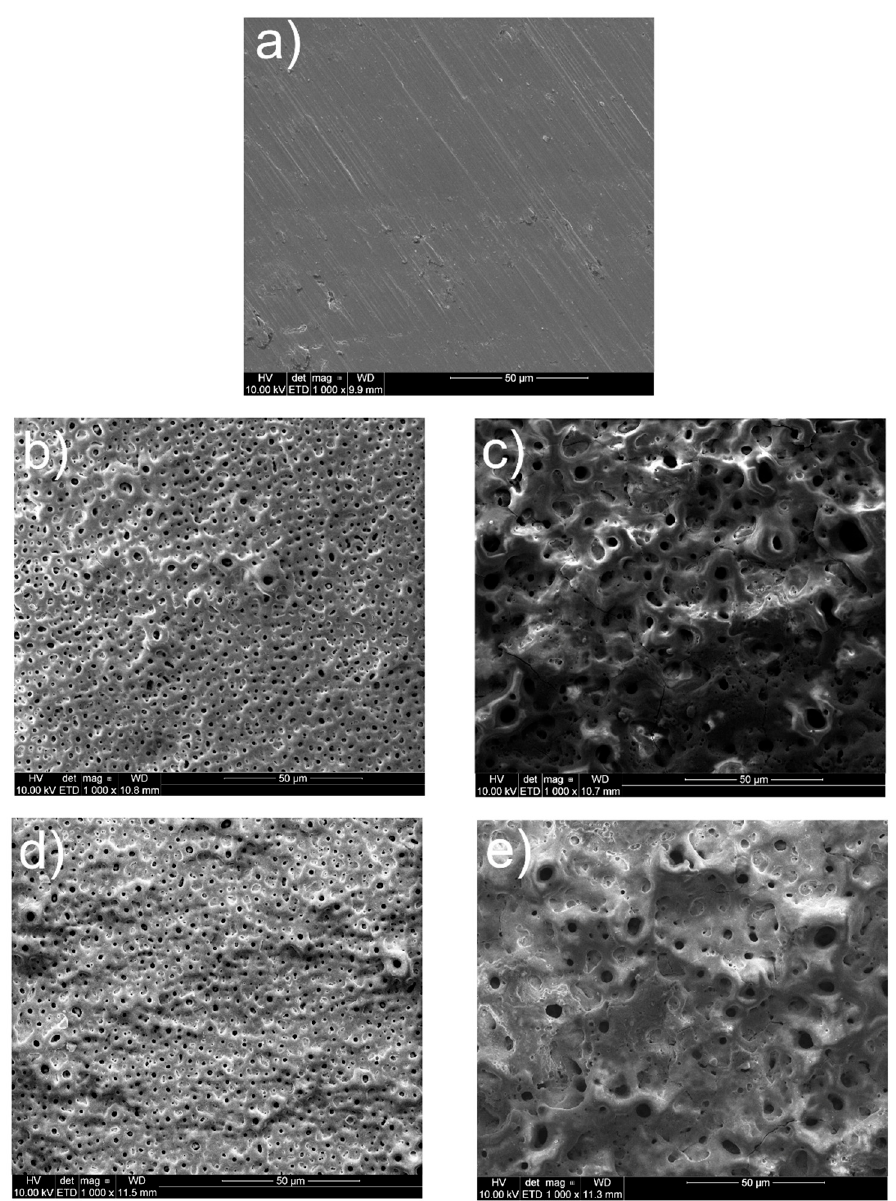
Figure 2. Microstructures of surfaces after different modifications: ( a ) ground, ( b ) ground and subjected to MAO at 300 V in CaP + GP solution, ( c ) ground and subjected to MAO at 400 V in CaP + GP solution, ( d ) ground and subjected to MAO at 300 V in CaP + GP + Ag solution, ( e ) ground and subjected to MAO at 400 V in CaP + GP + Ag solution.